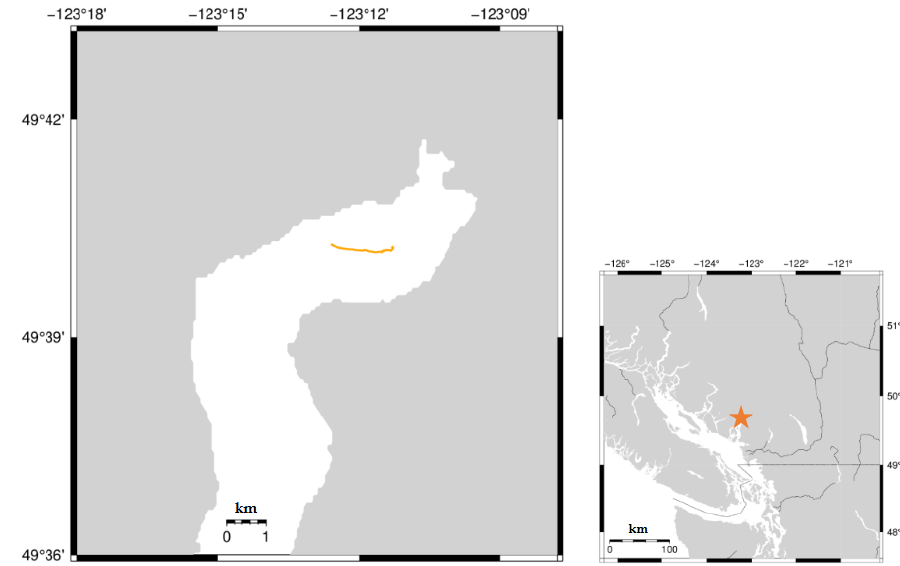
Figure 9. Experimental regions (Strait of Georgia) of multibeam water column data.